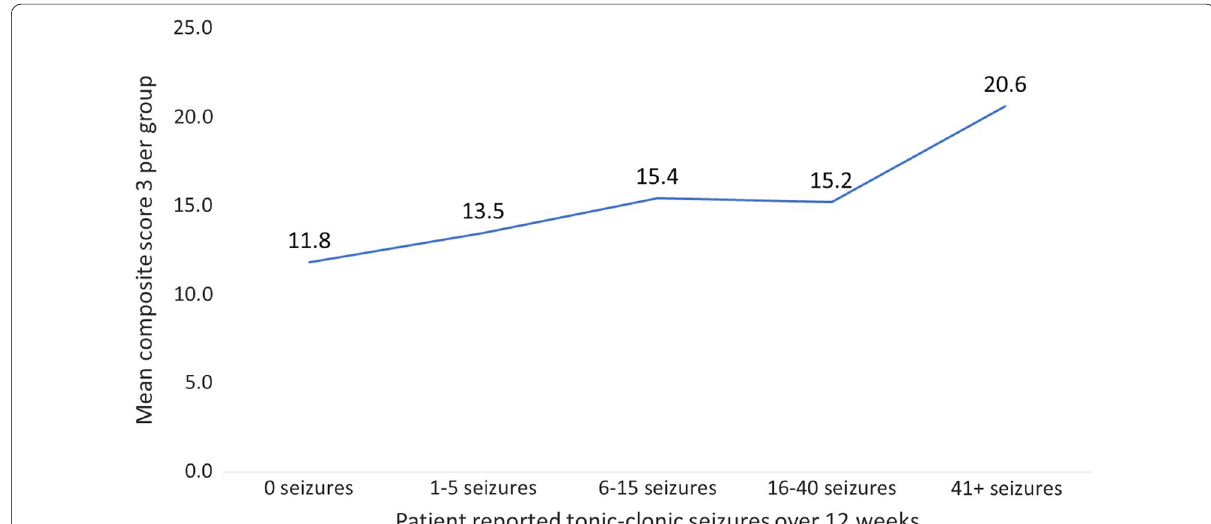
Table 4 Final HRQoL regression results following the step‑down regression approach